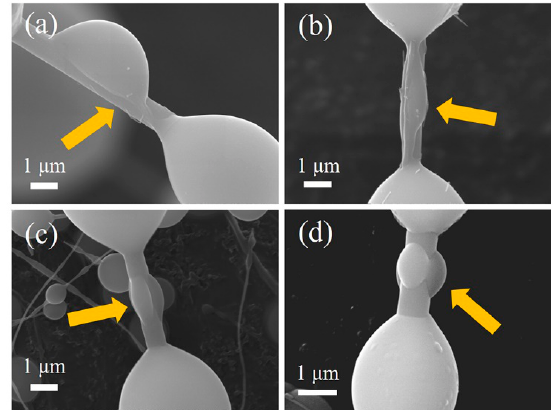
Figure 10. SEM images of the liquid SiO 2 movement of the as-prepared samples after firing at 1400 ◦ C. ( a ) SiO 2 bean; ( b ) Migration of SiO 2 droplet; ( c ) shrinkage of SiO 2 droplet; ( d ) SiO 2